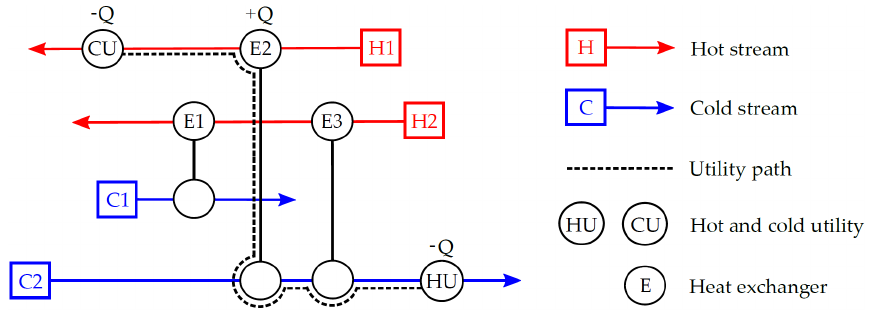
Figure 1. HEN containing a Utility Path.